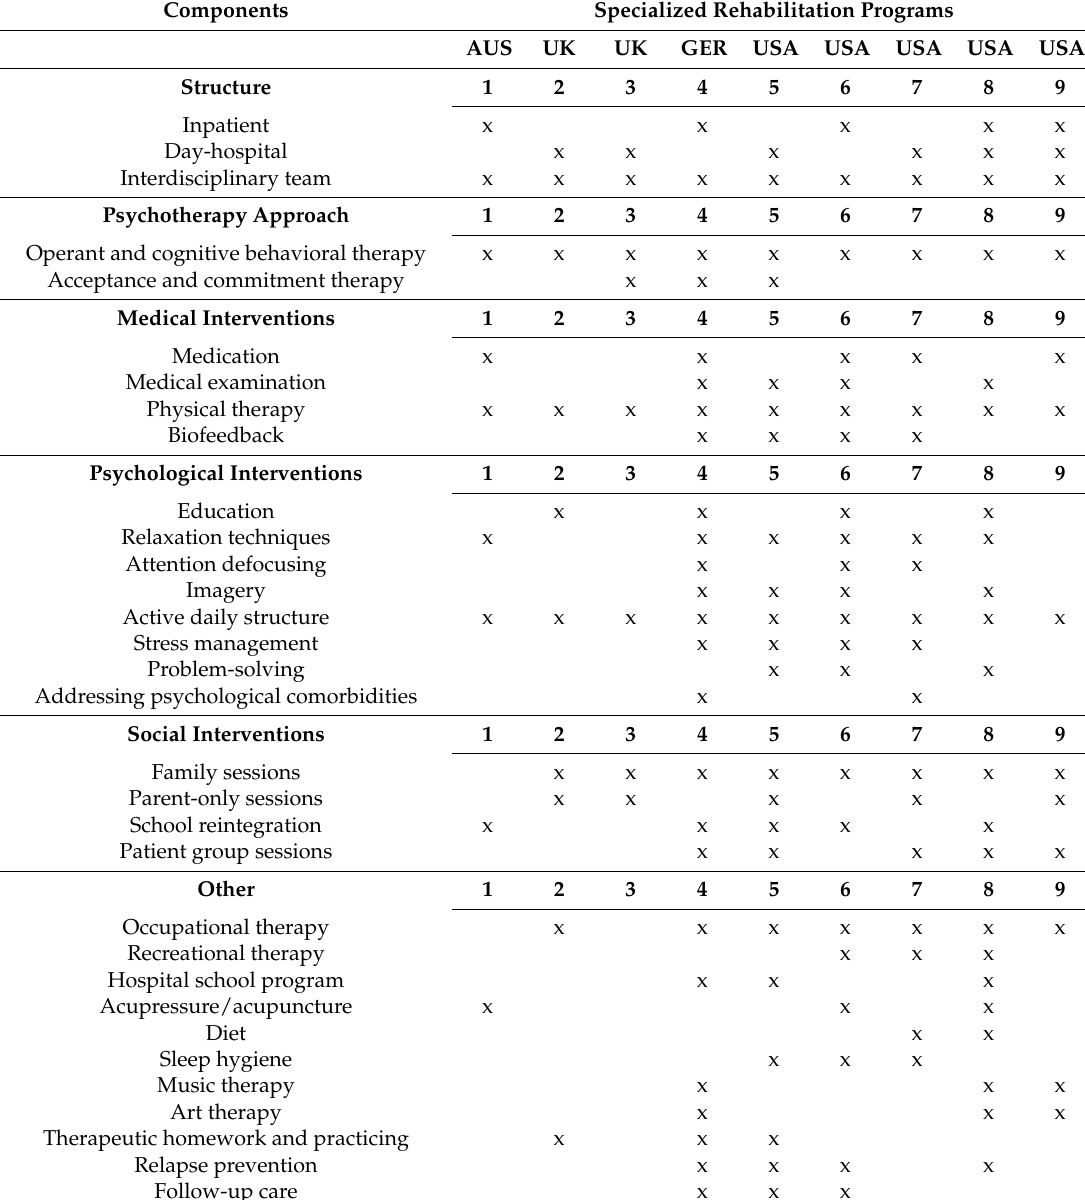
Table 2. Structural and therapeutic components of the specialized rehabilitation